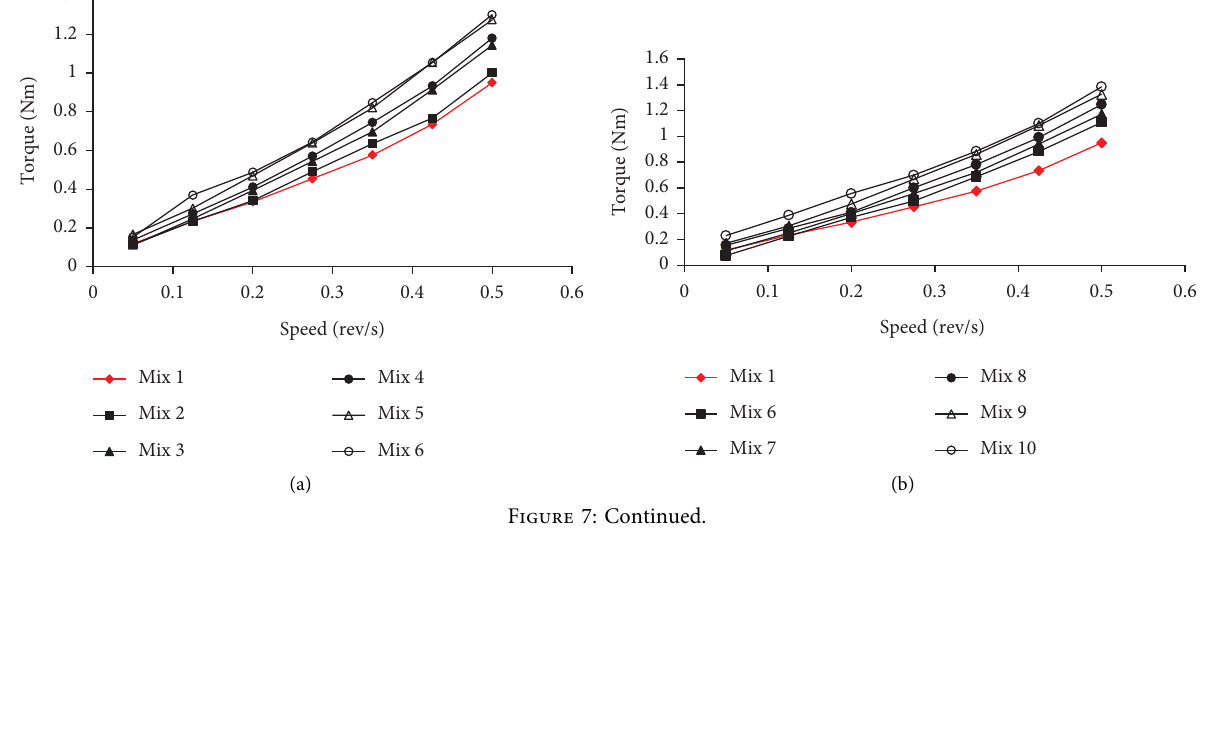
Figure 6: (a) Pictorial vision of the gas permeability test setup; (b) graphical show of the gas permeability test setup [24].